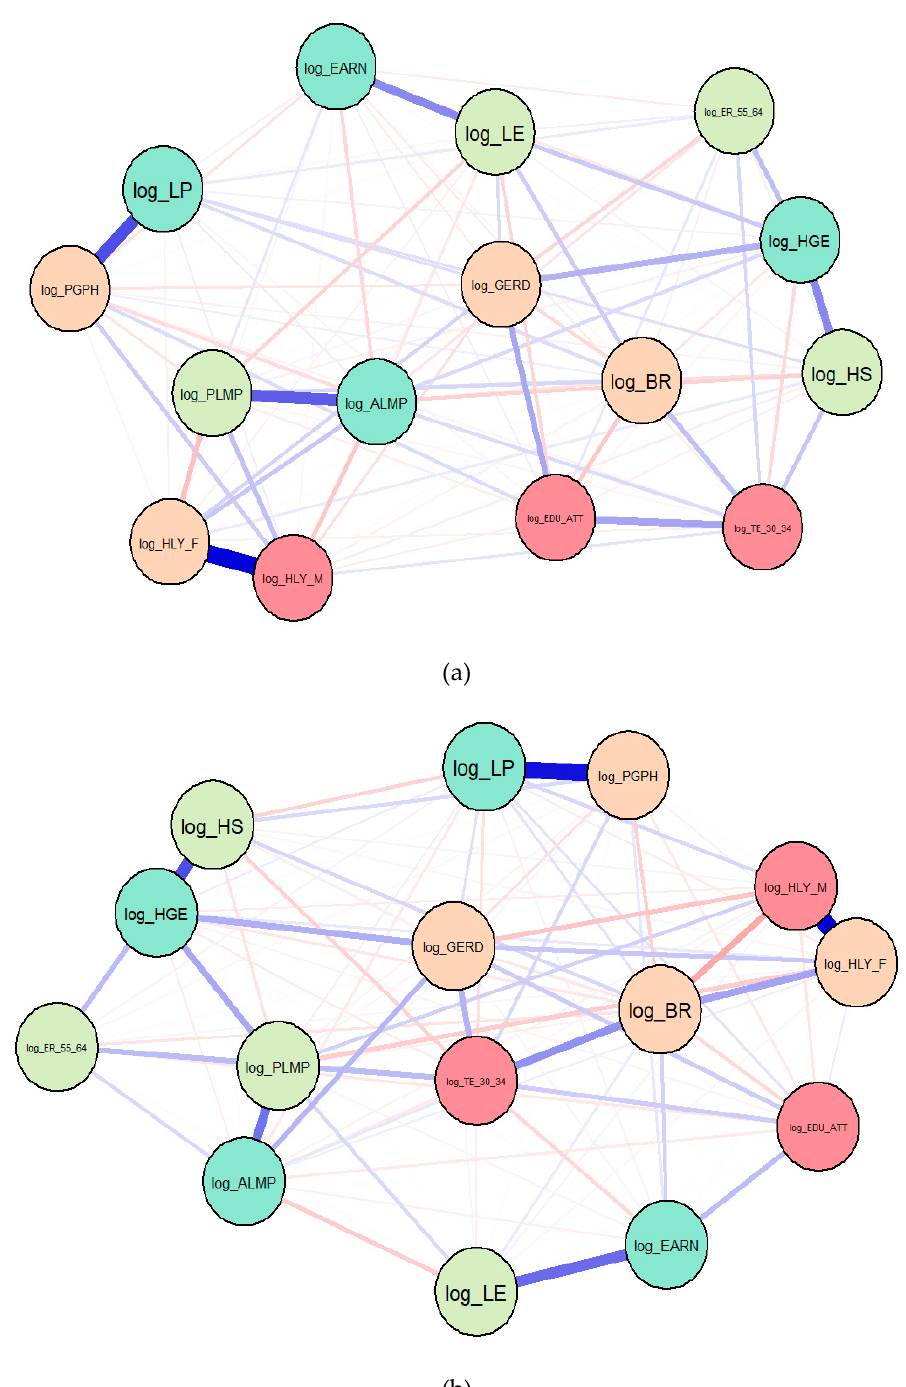
Figure 6. Gaussian graphical models (GGMs), 1995–2017, partial correlation (PCOR): ( a ) EU-13; ( b ) EU-15. Source: Authors’ research in R.